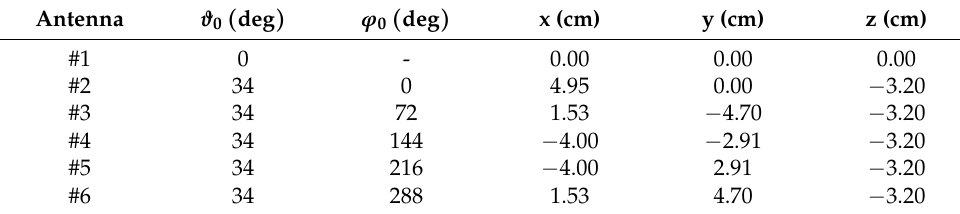
Figure 7. Pictorial representation of the observation model for the experiment. Table 2. Facing direction and center points of SBA antenna